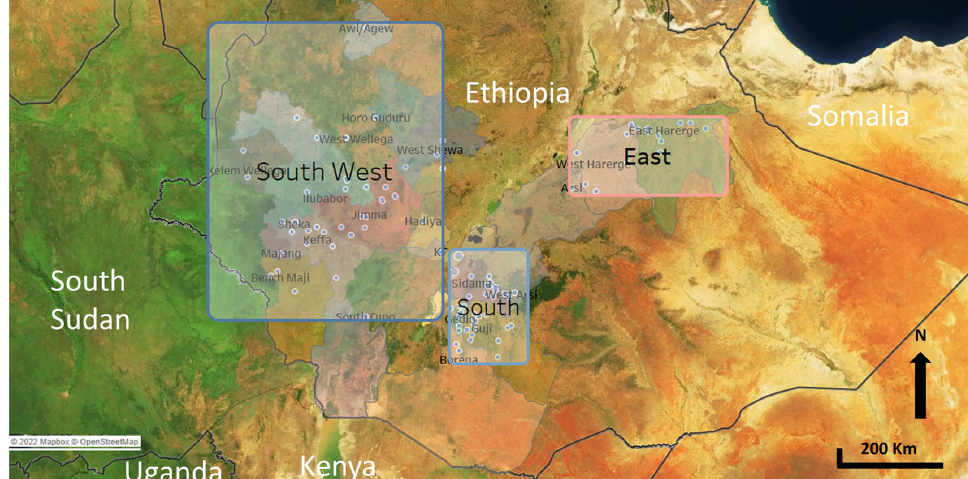
Figure 1. Geographical origin of Ethiopian coffee samples included in the study. Samples originate from several Woreda (districts) located in three regions: Southwest, south and east. Southwest and south regions correspond to the natural habitat of C. arabica in Ethiopia. Main Yemeni coffee producing governorates are highlighted. Samples in the study originate from governorates highlighted in red. The main historical ports for entry and exit of coffee beans in and from Yemen are indicated: Mocha and Aden.